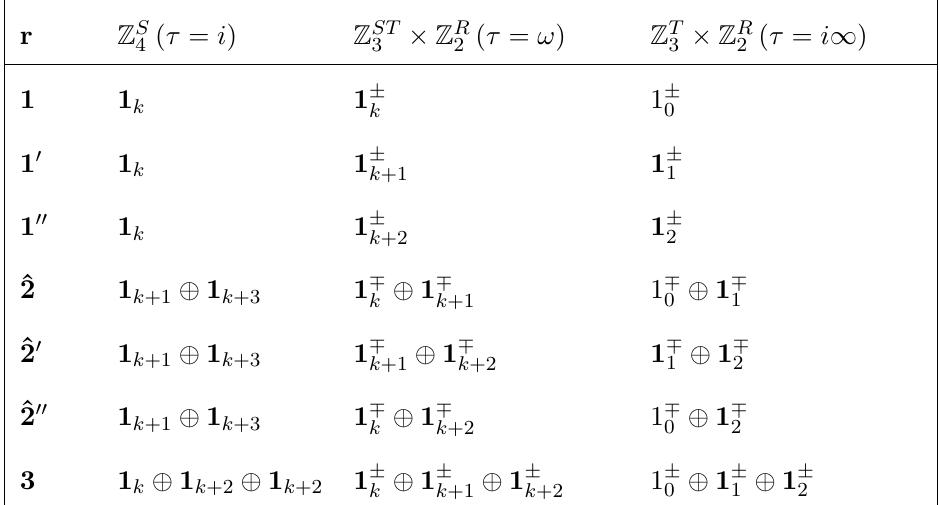
= T 0 under the residual ’ A 0 3 4